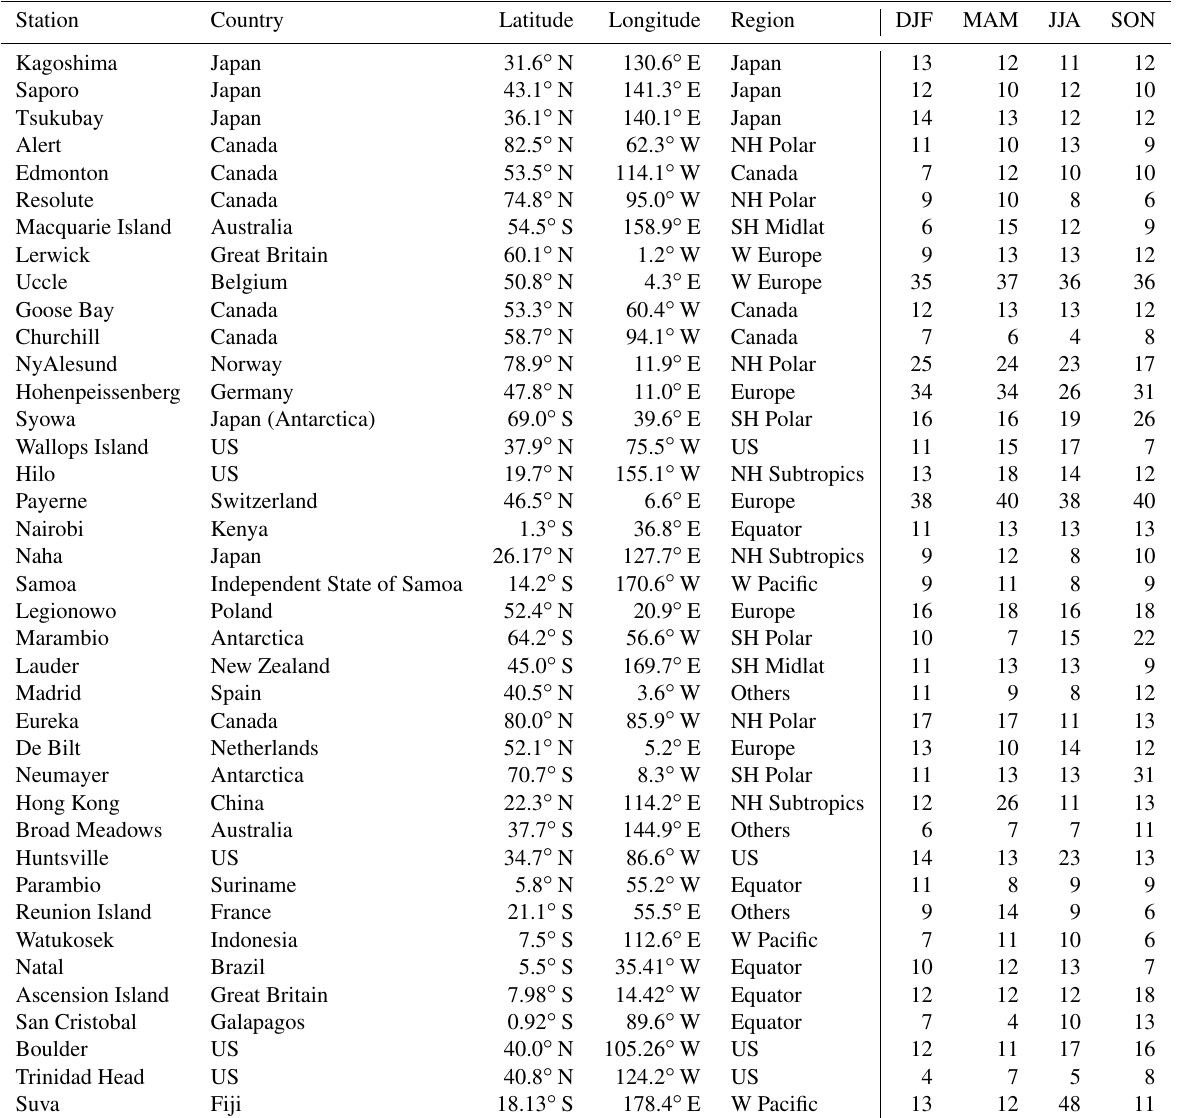
Table 3. Main information about the ozonesondes used in this study, including the location and number of available measurements for each season (DJF for December–January–February, MAM for March–April–May, JJA for June–July–August and SON for September–October–